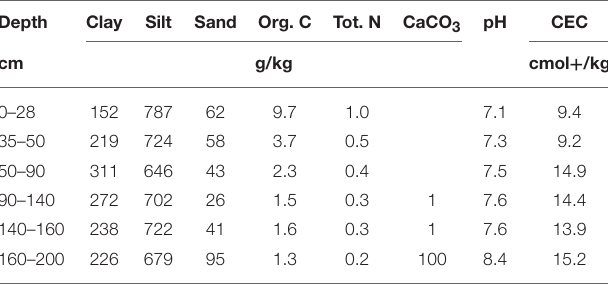
TABLE 1 | Main physico-chemical characteristics of the luvisol.